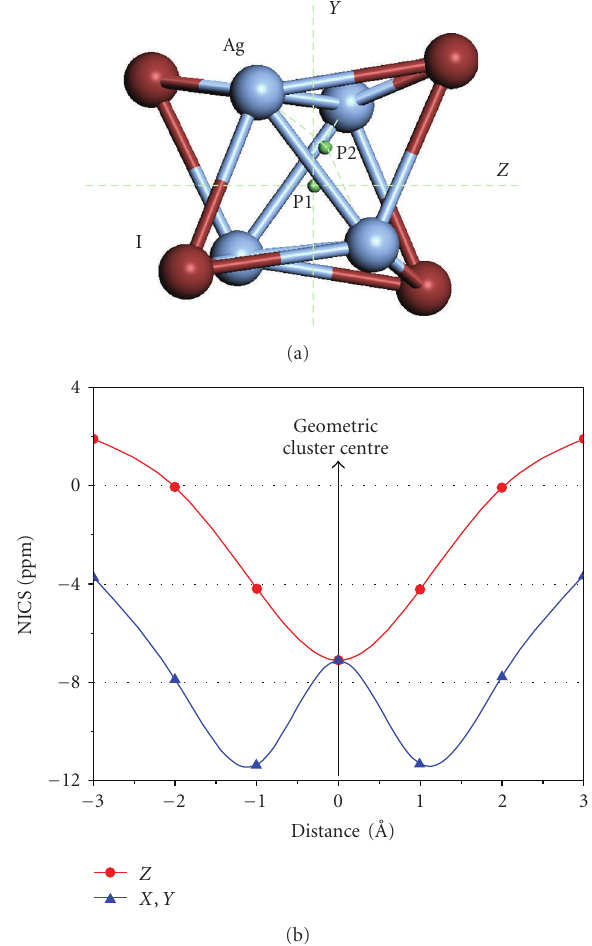
Figure 3: (a) The C 2 axes in the Ag 4 I 4 core of the cluster 4, along which NICS values have been calculated. (b) Plot of the NICS values calculated along the three C 2